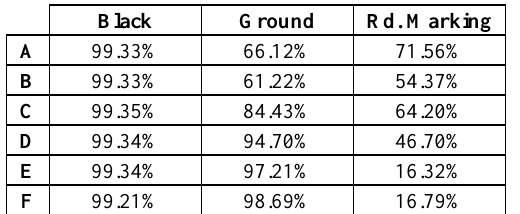
Figure 7. Class Legends